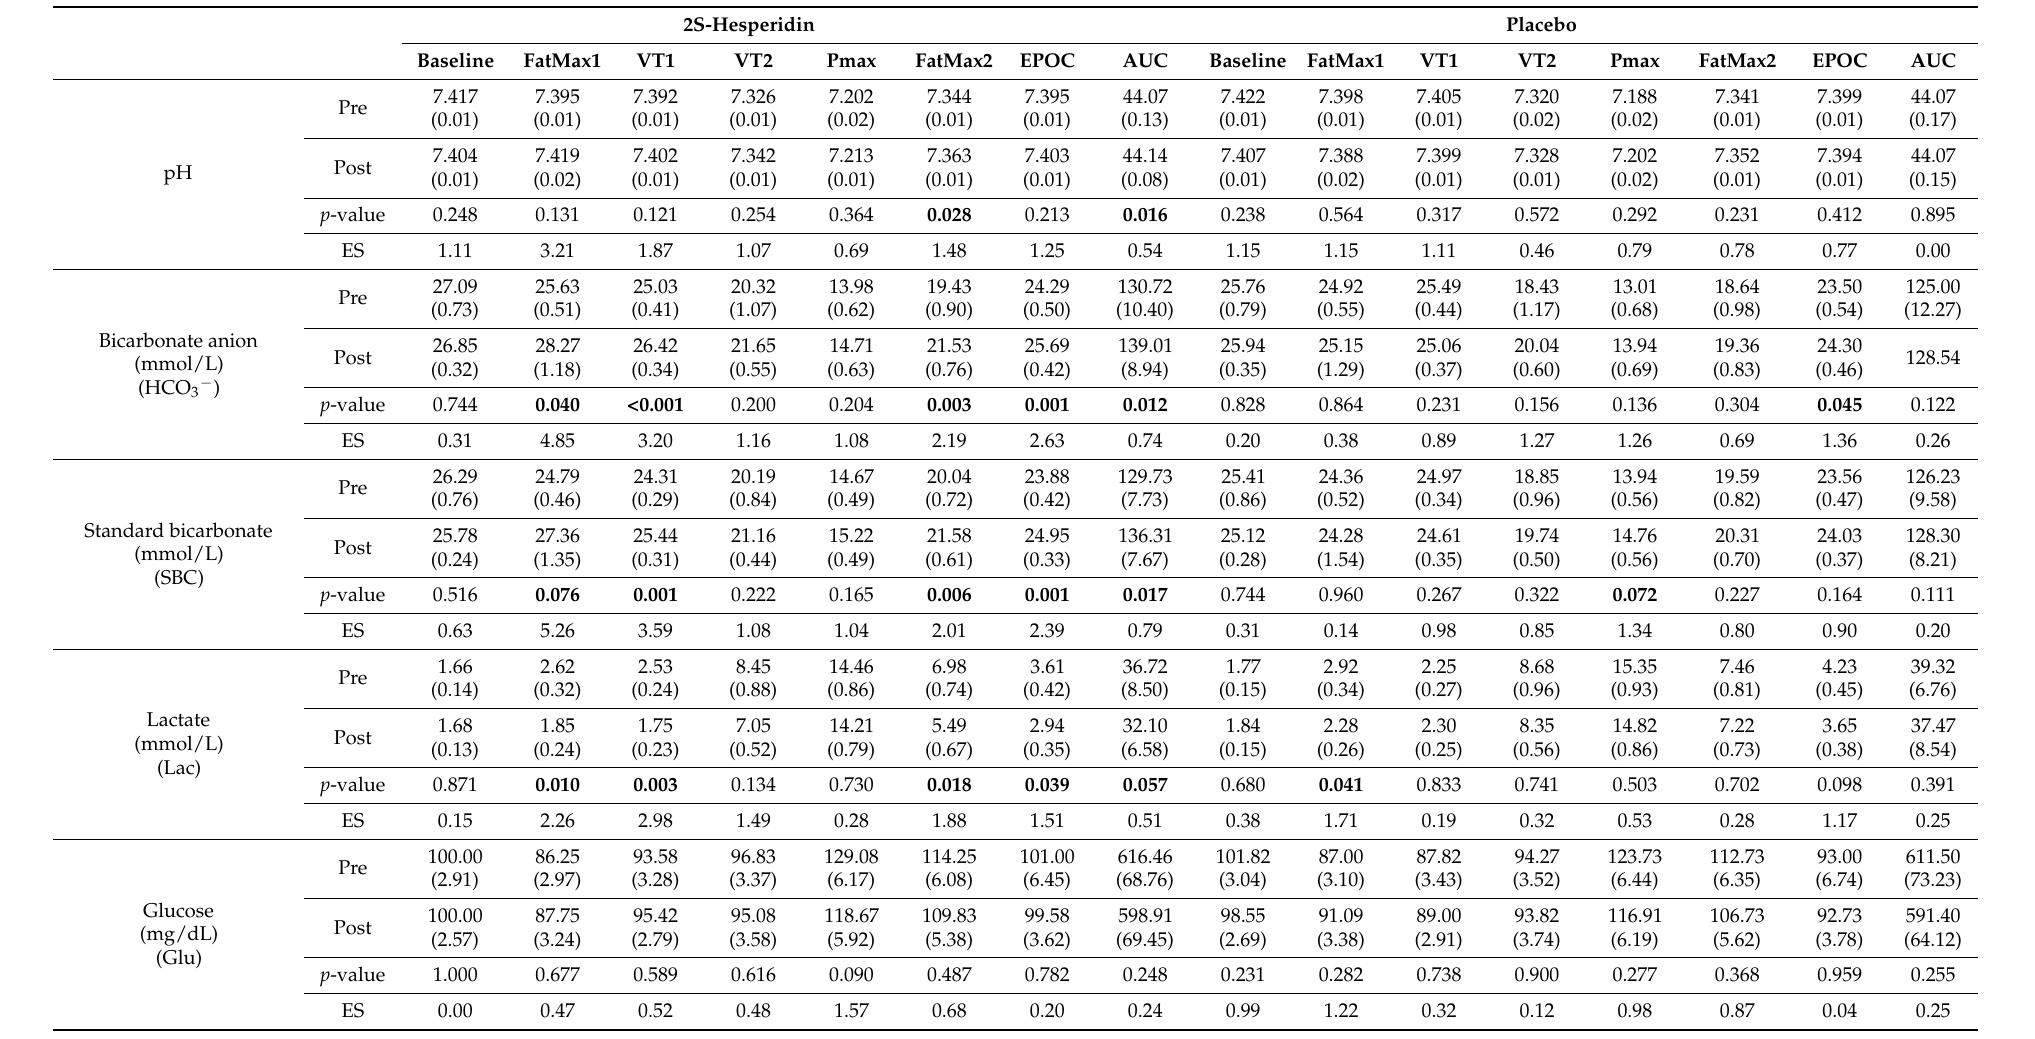
Table 4. Changes in the acid-base state and metabolic substrate in capillary finger blood at baseline, FatMax1, ventilatory threshold 1 (VT1), ventilatory threshold 2 (VT2), power output maximum (P MAX ), FatMax2 and EPOC during the rectangular test. Values are mean (SD) and effect size (ES). 2S-Hesperidin